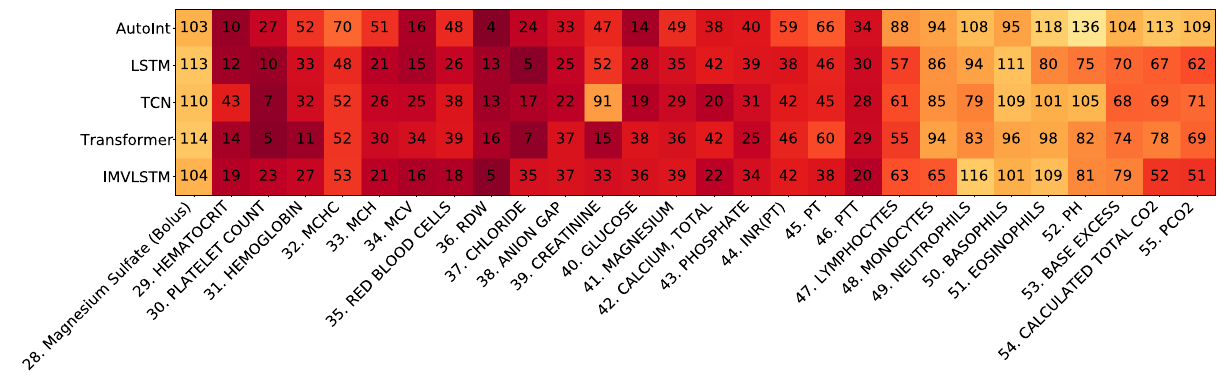
Figure 10. Visualization of global feature importance ranks (feature 28-55).